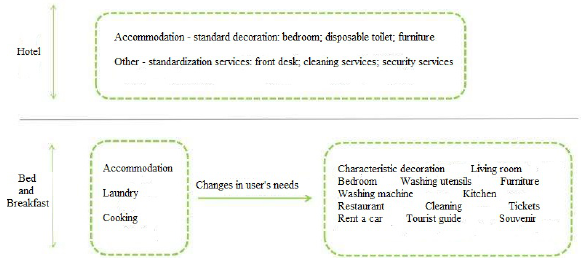
Fig. 1. The difference between hotel and bed and